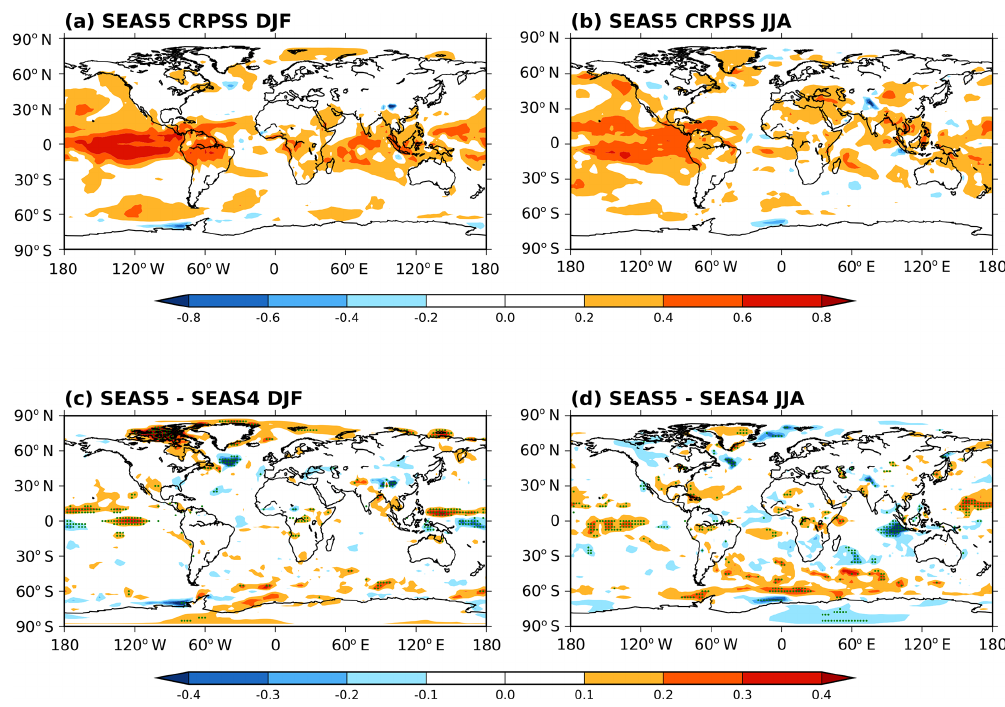
Figure 21. (a, b) CRPSS maps of 2m temperature for SEAS5 with reference to ERA-Interim climatology in (a) DJF and (b) JJA. (c, d) The change in 2m temperature CRPSS score between SEAS5 and SEAS4 in (c) DJF and (d) JJA. Green stippling is plotted at p < 0 . 05.